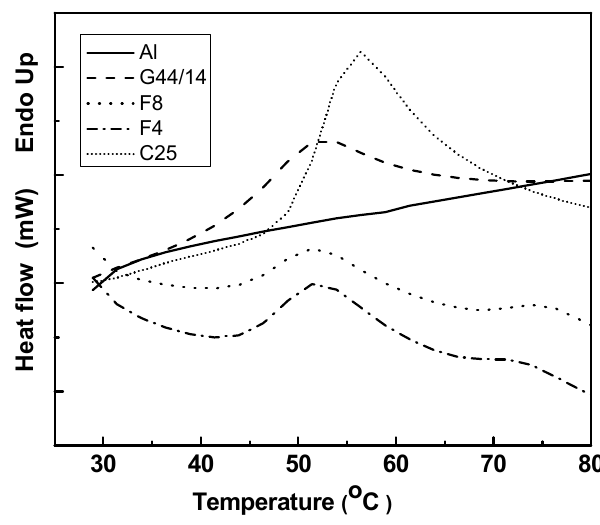
Figure 2. DSC thermograms of AL-loaded SLPs (formulations F4 and F8) and their ingredients.